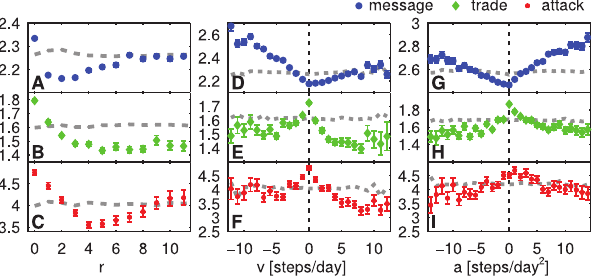
Fig 4. Average number of (uni-directional) interactions per day as a function of r β , v β , and a β . Errorbars are standard deviations of the mean. The results for randomized data are shown with dashed gray lines. Clearly, interaction intensity is strongest for players in the same sector ( r = 0). For trade and attack, stationary players (with velocity and acceleration zero) interact the most. For messages, interaction is most intense for players who move towards each other but slow